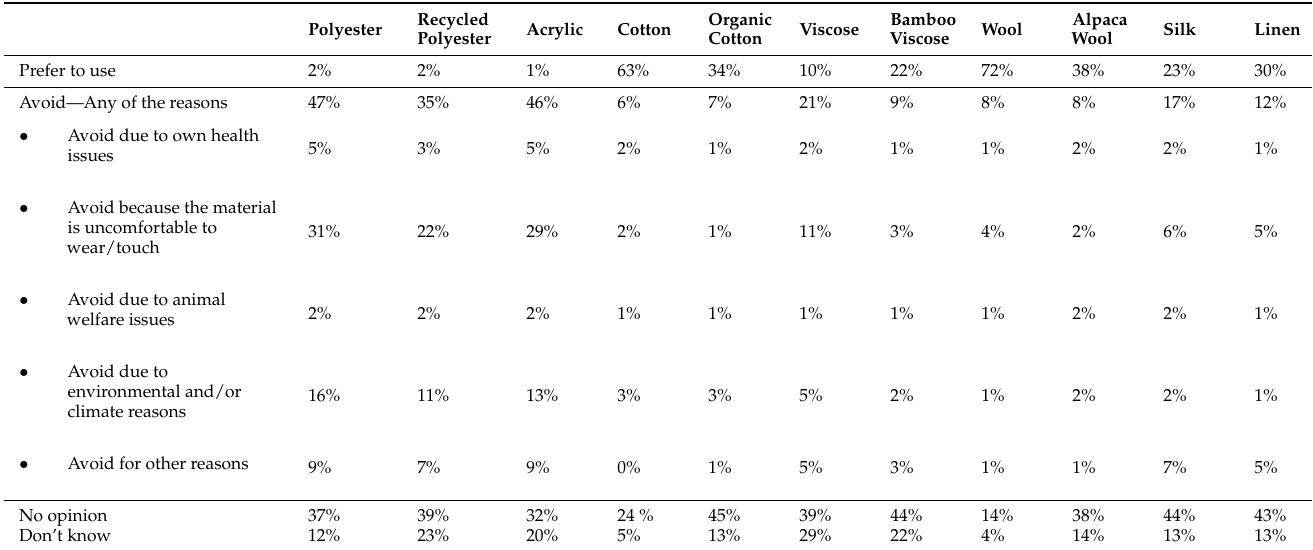
Table 4. Distribution of fiber preference and avoidance